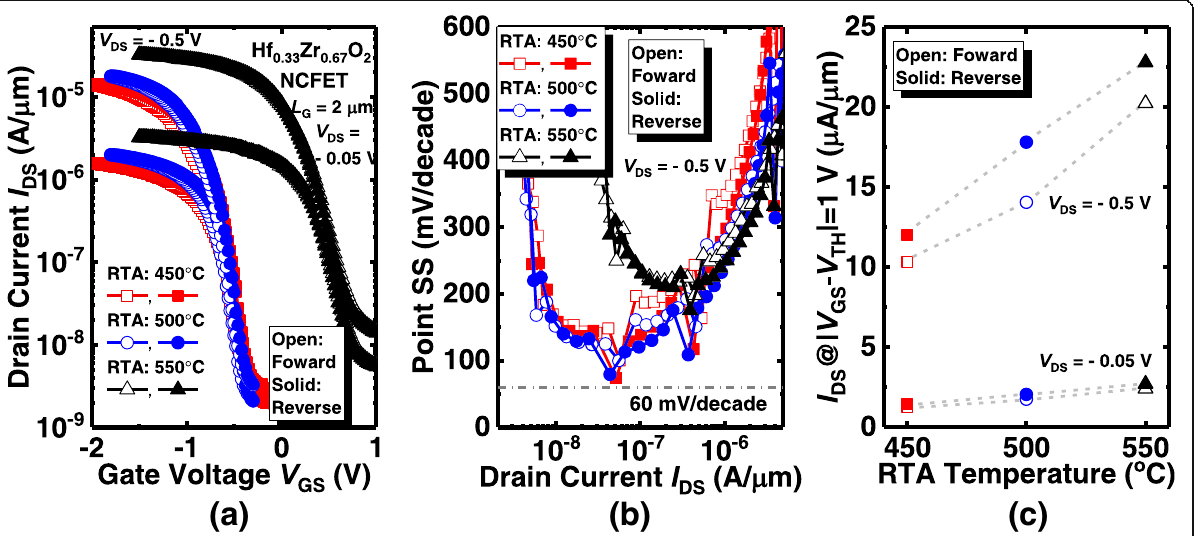
Fig. 5 ( a ) Measured transfer characteristics of the Hf 0.33 Zr 0.67 O 2 NC Ge pFETs annealed from 450 to 550 °C. ( b ) Point SS as a function of I DS for the Hf 0.33 Zr 0.67 O 2 devices. ( c ) I DS for the ferroelectric NC transistors with different annealing temperatures at a gate overdrive of 1